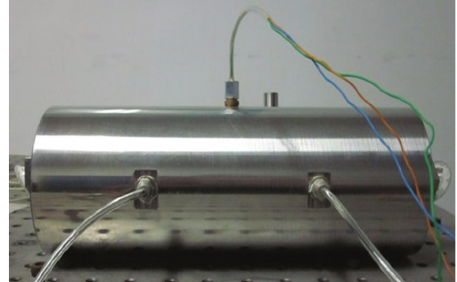
Figure 3: The physical figure of the fabricated PA